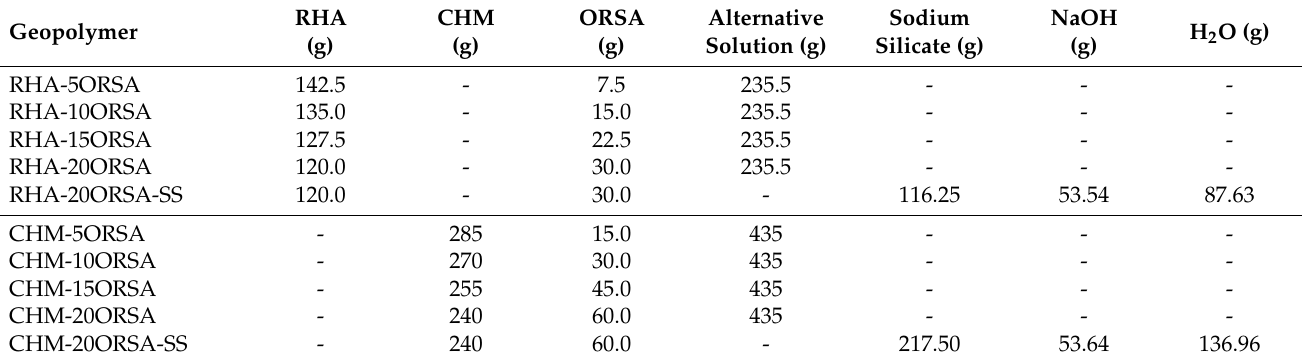
Table 2. Mix compositions of the